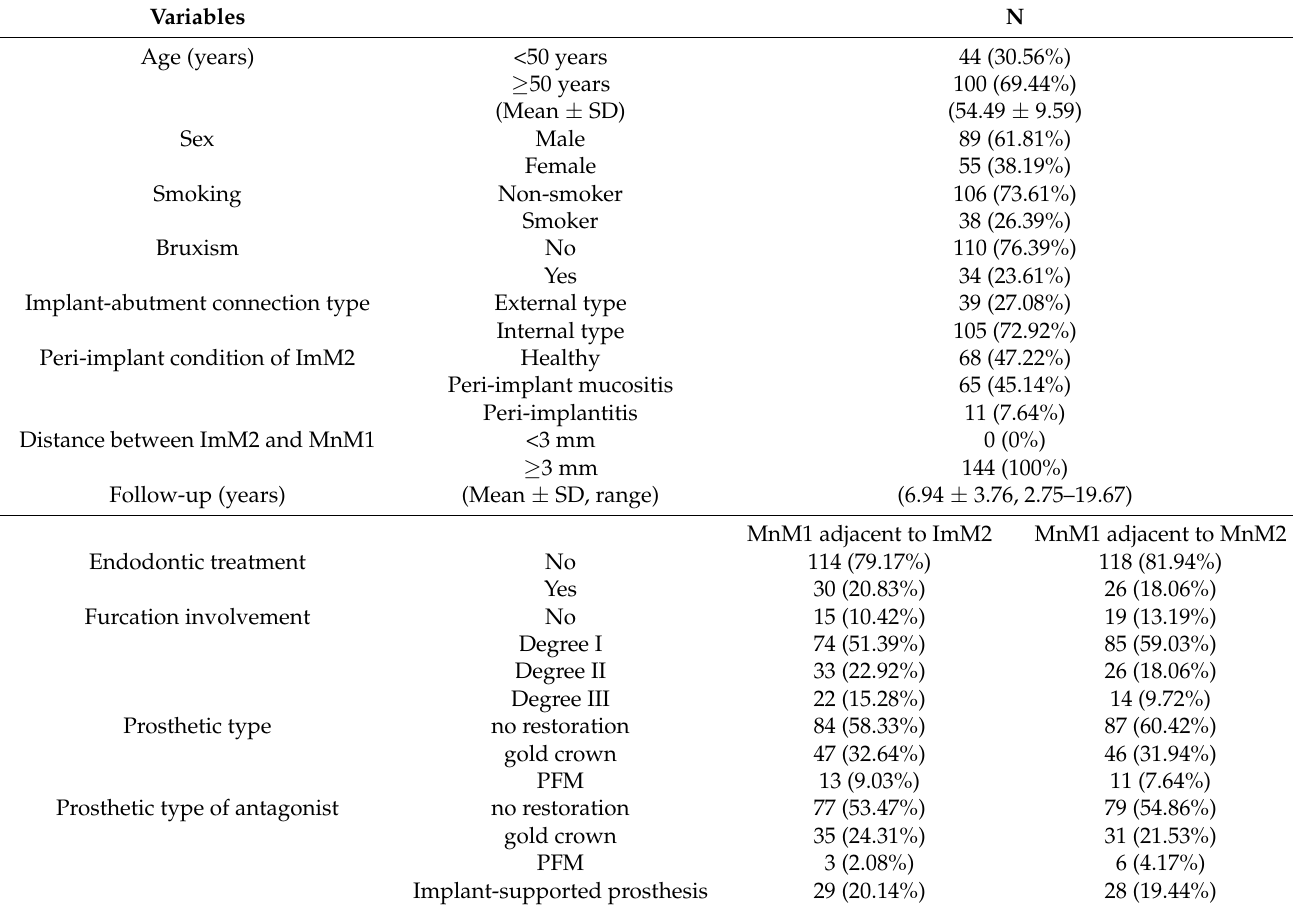
Table 1. Patient demographic